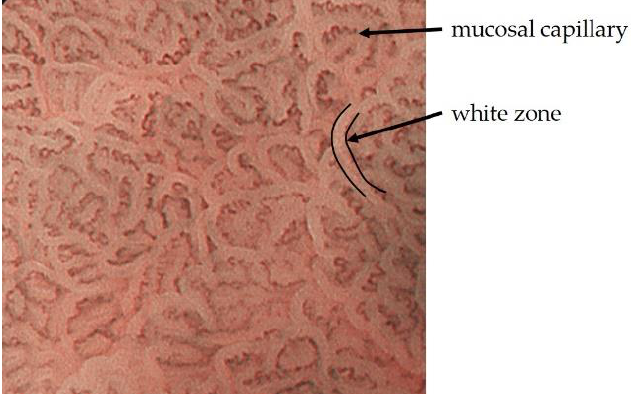
Figure 1. Mucosal capillaries are observed as low signal compared to the surrounding tissue. WZ reflects the morphology of the marginal crypt epithelium.